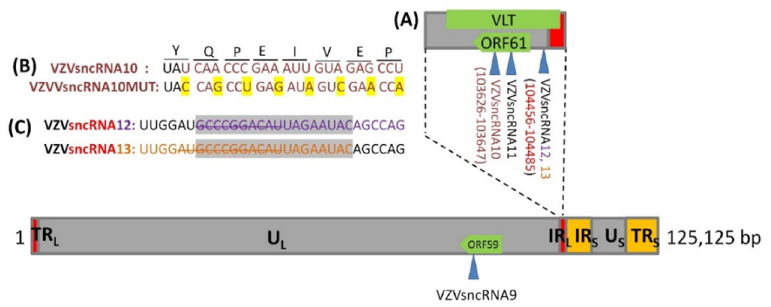
Figure 1. Genomic localization of VZVsncRNA10, VZVsncRNA12 VZVsncRNA13 expression and mutagenesis ( A ) depicts the region of the VZV genome containing the VZVsncRNA studied. Ar- rowheads indicate the VZVsncRNA coded by the lower viral DNA strand and deriving from a right to left primary transcript that is predicted to encode ORF61. ( B ) Mutations introduced into VZVsnc10MUT: the upper sequence shows the original sequence while the lower sequence shows the synonymous mutations introduced by mutagenesis highlighted in yellow. ( C ) Sequences of VZVsncRNA12 (purple letters) and VZVsncRNA13 (orange letters) deleted in VZVsnc12-13DEL l are indicated with a strikeout. The portion of VZVsncRNA12 and VZVsncRNA13 that overlap is highlighted in gray. The sncRNA is shown in the correct direction.